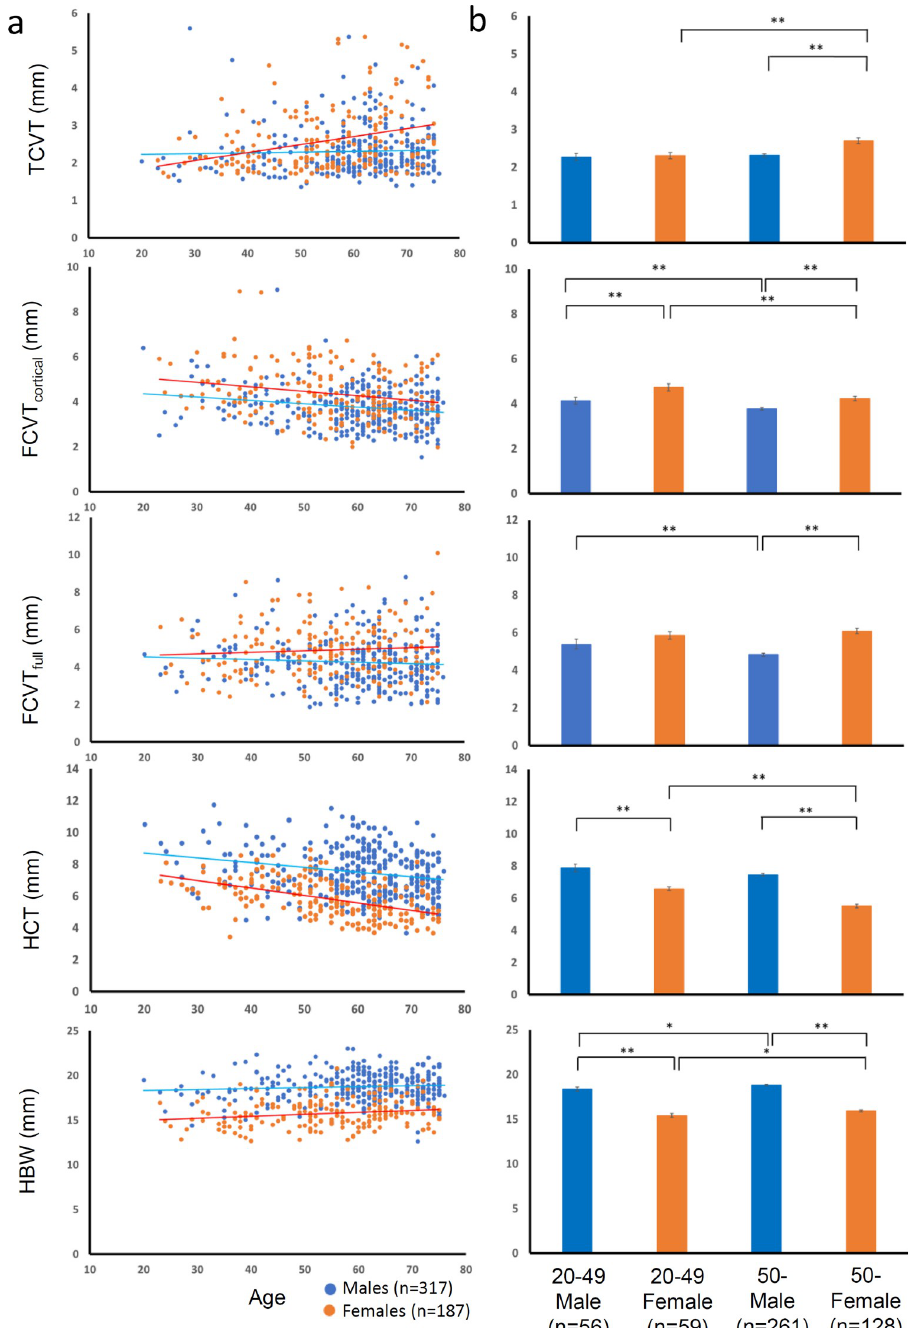
Fig 2. Associations of sex and age with measurements of bone thickness. (a) Plots of measurement value versus age and regression lines for males (blue) and females (orange). (b) Bar charts for sex and age groups. * P < 0.05 and ** P <